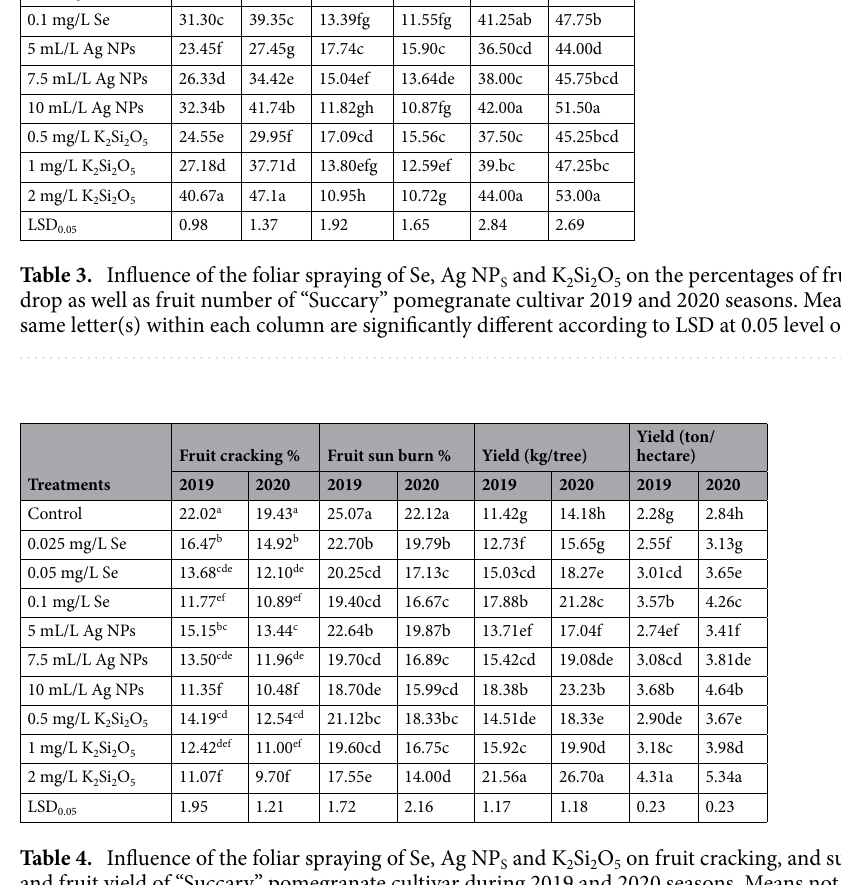
Table 4. Influence of the foliar spraying of Se, Ag NP S and K 2 Si 2 O 5 on fruit cracking, and sunburn percentages and fruit yield of “Succary” pomegranate cultivar during 2019 and 2020 seasons. Means not sharing the same letter(s) within each column are significantly different according to LSD at 0.05 level of significance.